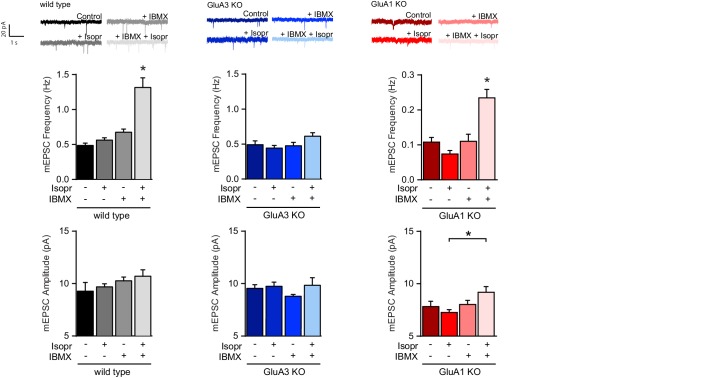
β–adrenergic activation induces GluA2/3–plasticity.Brain slices were acutely isolated from mature WT and littermate GluA3-KO mice, or GluA1-KO mice. Example traces, average mEPSC frequencies and amplitudes from CA1 neurons incubated with no drugs, b-AR agonist isoproterenol, PDE blocker IBMX, or isoproterenol plus IBMX (WT: ctrl n=13, Iso n=11, IBMX n=7, Iso + IBMX n=9; GluA3-KO: ctrl n=15, Iso n=7, IBMX n=7, Iso+IBMX n=4; GluA1-KO: ctrl n=5, Iso n=4, IBMX n=8, Iso+IBMX n=6). Isoproterenol in presence of IBMX increases mEPSC frequency in WT (ANOVA, ctrl vs Isopr: p=0.8; IBMX vs Isopr/IBMX: p<0.0001), and GluA1-KO (ANOVA, ctrl vs Isopr: p=0.4; IBMX vs Isopr/IBMX: p=0.001), but not in GluA3-KO (ANOVA, ctrl vs Isopr: p=0.9; IBMX vs Isopr/IBMX: p=0.5). Isoproterenol/IBMX did not affect average mEPSC amplitude in WT (ANOVA, p=0.4), in GluA3-KO (ANOVA, p=0.4), or in GluA1-KO neurons (ANOVA, Isopr vs isopr/IBMX p=0.045). Error bars indicate SEM, * indicates p<0.05.